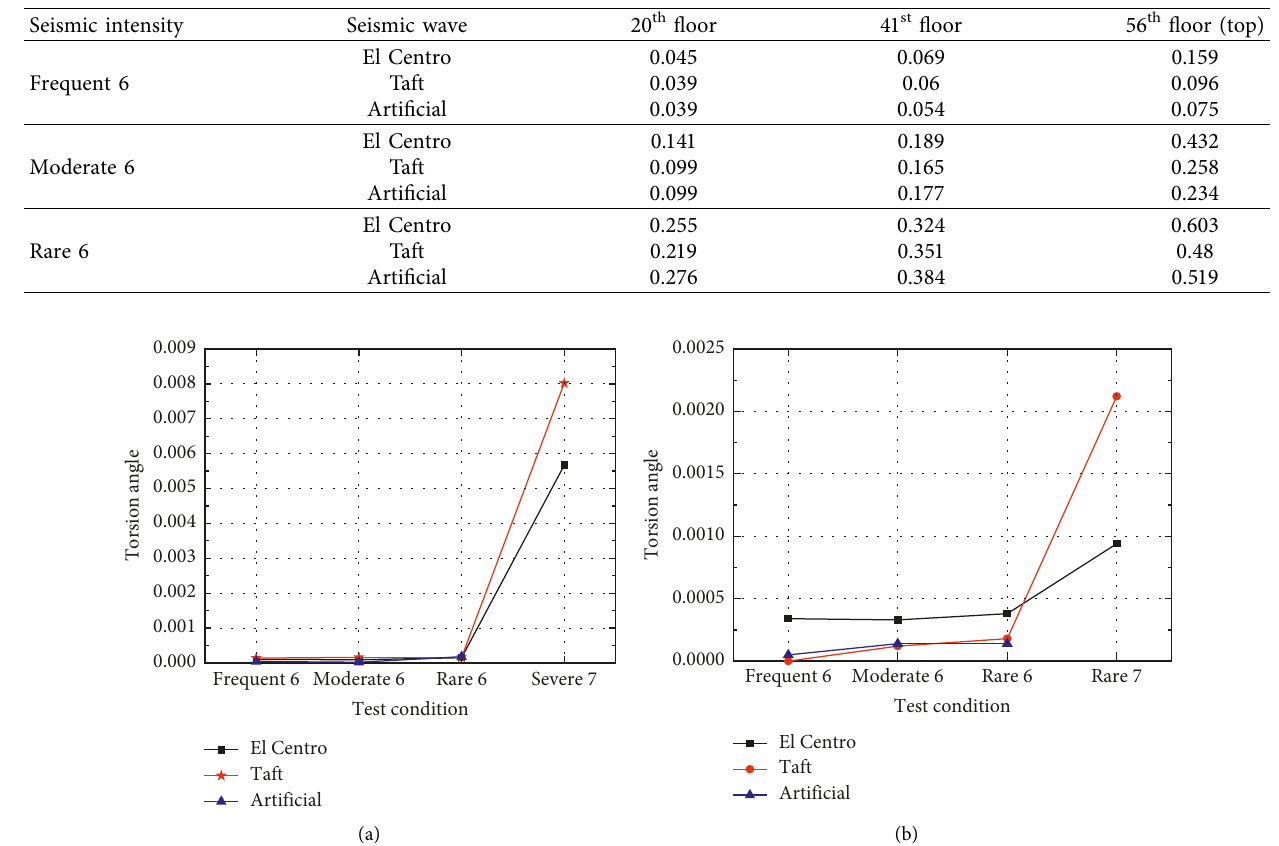
Table 10: Story drift of the structure under different seismic waves.